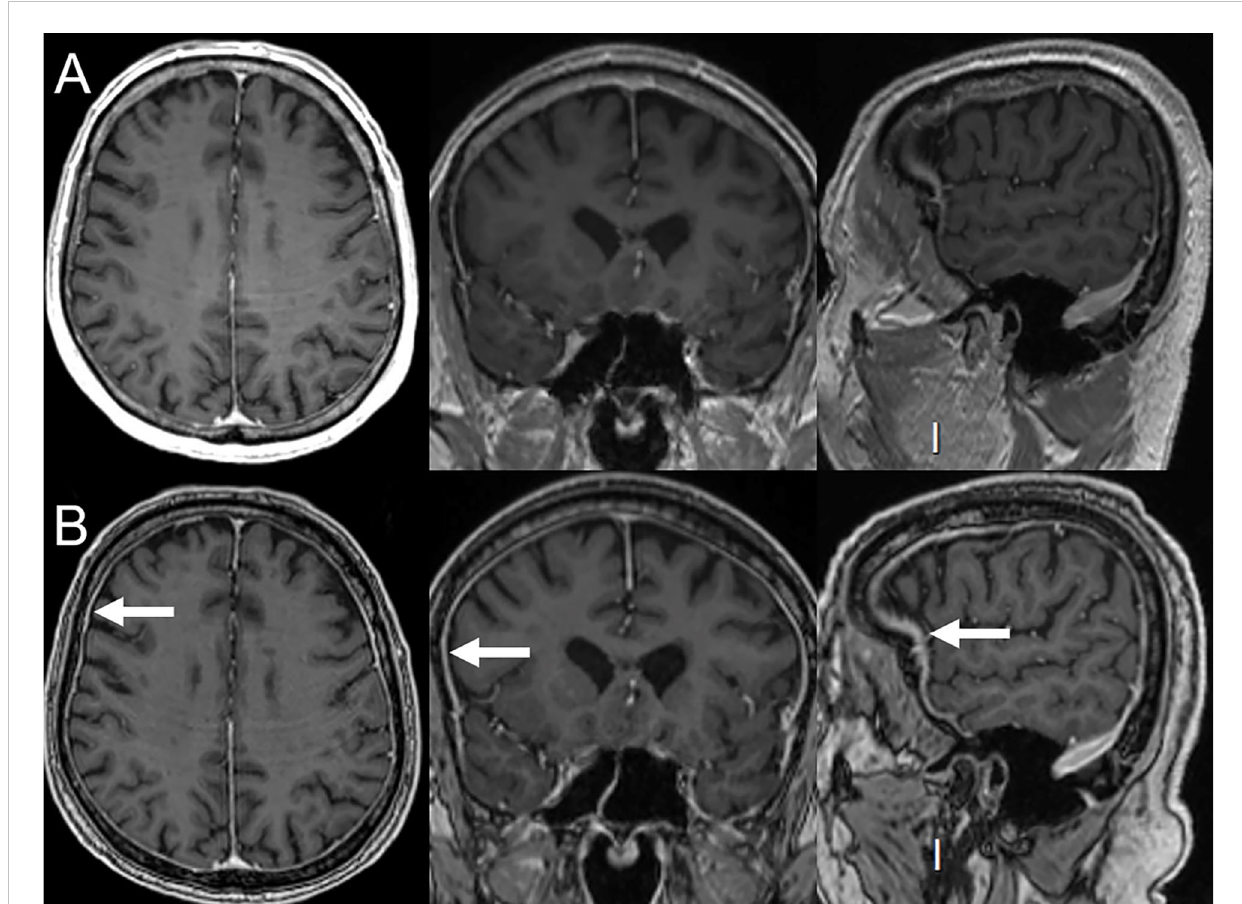
FIGURE 8 Immune-related aseptic meningitis in a 78-year-old female with NSCLC treated with ipilimumab (anti-CTLA-4) and nivolumab (anti-PD-1). (A) Normal brain MRI (axial, coronal and sagittal plans) performed 6 months prior to immunotherapy. After 3 cycles of ipilimumab and nivolumab, the patient developed headaches. (B) MRI performed 2 months after the beginning of immunotherapy showed smooth diffuse dura mater thickening (arrows) compatible with aseptical meningitis. Patient ’ s symptoms and signs of in fl ammation on MRI disappeared upon immunotherapy